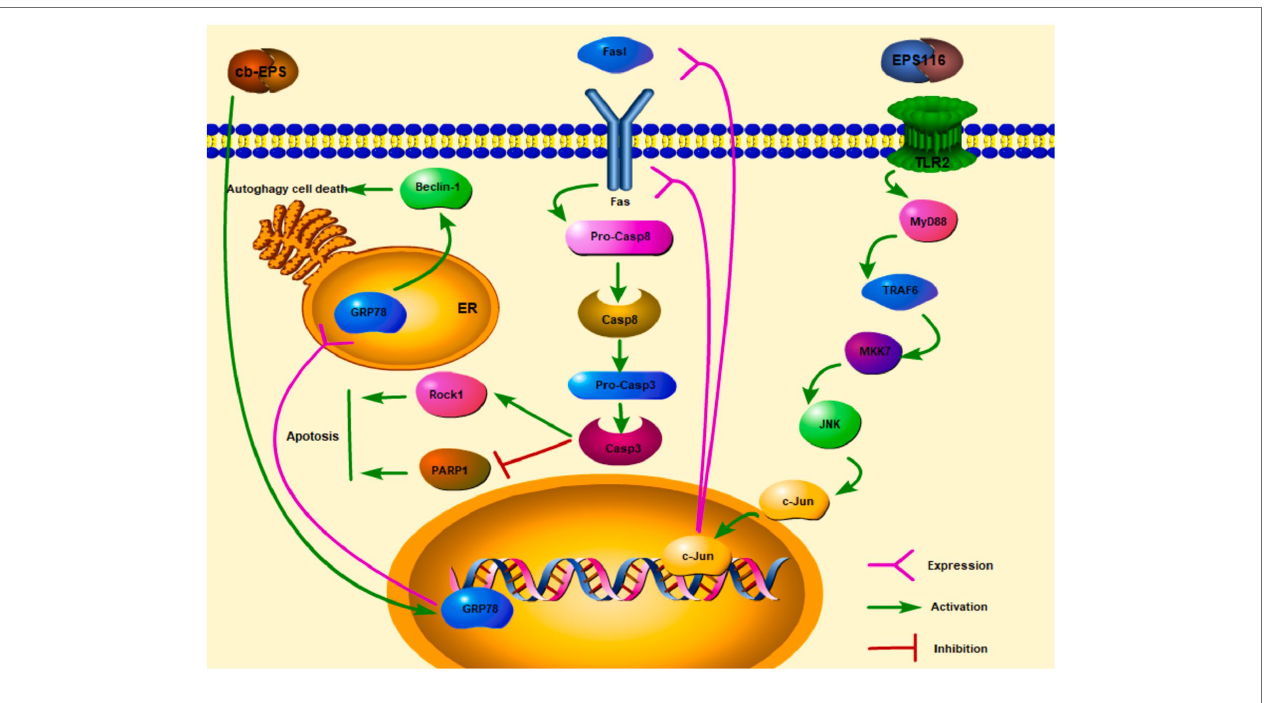
FIGURE 1 | Extracellular polysaccharides (EPS) of lactic acid bacteria kills cancer cells via apoptosis and autophagy